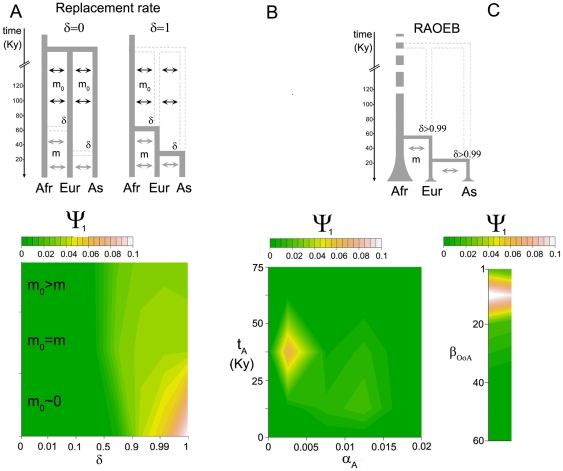
Model and parameter best-fitted estimations.(A) Simulations considering different levels of replacement of archaic hominids by modern humans. We performed 8 sets of 105 simulations: one set for a replacement rate δ = 0, one for δ = 1, 3 sets for 0≤δ≤0.01, 0≤δ≤0.1 and 0≤δ≤0.5, and 3 sets for δ≥0.5, δ≥0.9 and δ≥0.99. For each of the 8 sets, we considered three models of ancestral migration (represented by black arrows): a residual ancestral migration rate (m0∼10−10), an ancestral migration rate with the same range (10−6 to 4×10−3) as m the current migration rate (represented by gray arrows), and an ancestral migration twice higher than m. Among the 24 models tested, the model assuming a complete replacement rate of archaic hominids (δ = 1) and a residual ancestral migration (m0∼10−10) exhibited the significantly highest ψ1 except when compared with the model assuming an almost complete replacement rate of archaic hominids (δ≥0.99). This best-fitted range of parameters (δ≥0.99 and m0∼10−10), indicated by the yellow/orange/white area (A), was therefore used to simulate the African expansion (B) and the non African bottleneck (C). We performed three sets of 105 simulations for the onset tA: 0≤tA≤25 Kyears, 25≤tA≤50 Kyears and 50≤tA≤75 Kyears. For each of the three sets, we considered 5 models of growth rate αA parameters; αA = 0, 0≤αA≤0.005, 0.005≤αA≤0.01, 0.01≤αA≤0.015 and 0.015≤αA≤0.02. Among the 15 models tested, the best-fitted ranges of parameters (ψ1 significantly higher than ψ1 of the constant size model αA = 0, P<0.01) are indicated by the yellow/orange/white area (B). Likewise, we performed 5 sets of 105 simulations assuming bottlenecks intensities βOoA, starting at the time of the out-of-Africa exodus (TOoA) and ending at the independent Neolithic expansions in Europe and east-Asia: βOoA = 1, 1≤βOoA≤2, 2≤βOoA≤20, 20≤βOoA≤40 and 40≤βOoA≤60. The best-fitted range of parameter (ψ1 significant higher than ψ1 of the constant size model βOoA = 1, P<0.01), indicated by the yellow/orange/white area (C), was obtained with the set of priors 2≤βOoA≤20. The distributions used are specified in Table S4.